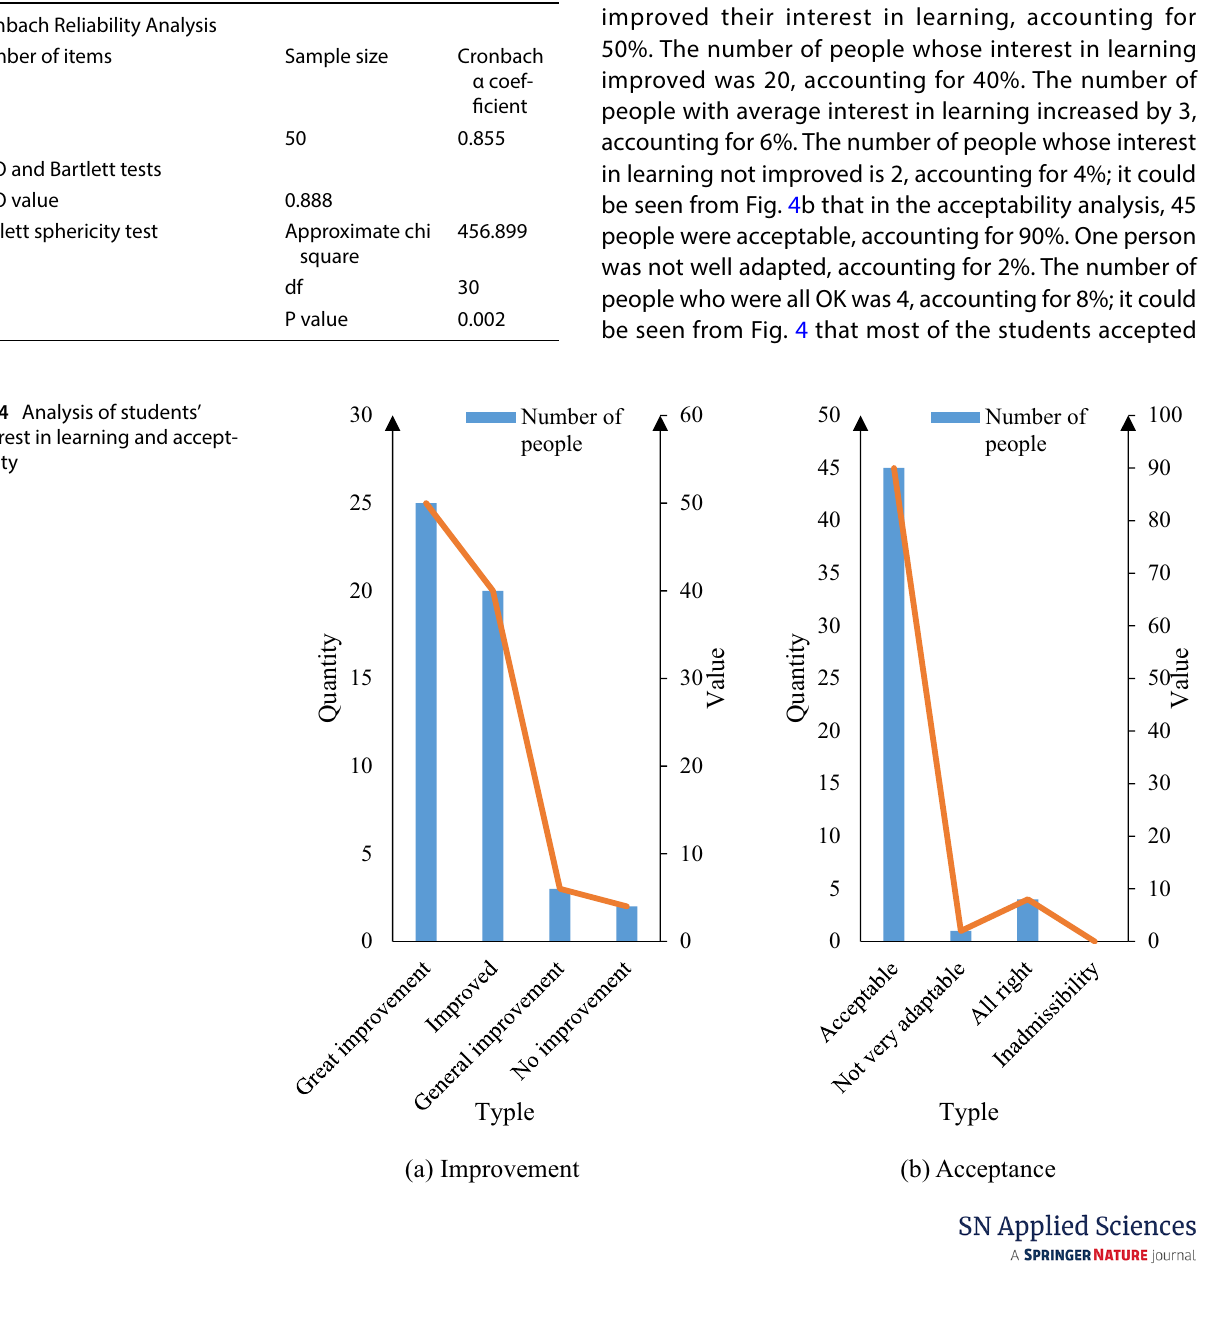
Table 2 Results of SPSS reliability and validity analysis